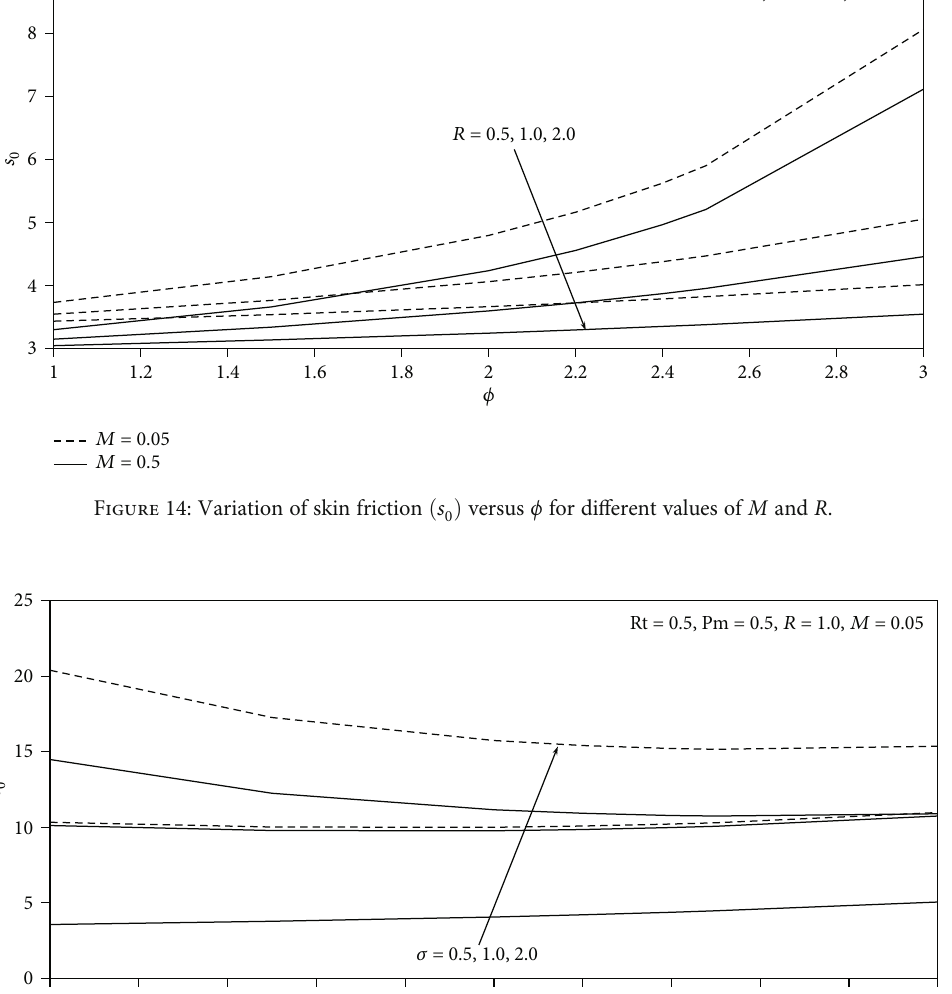
Figure 15: Variation of skin friction ð s